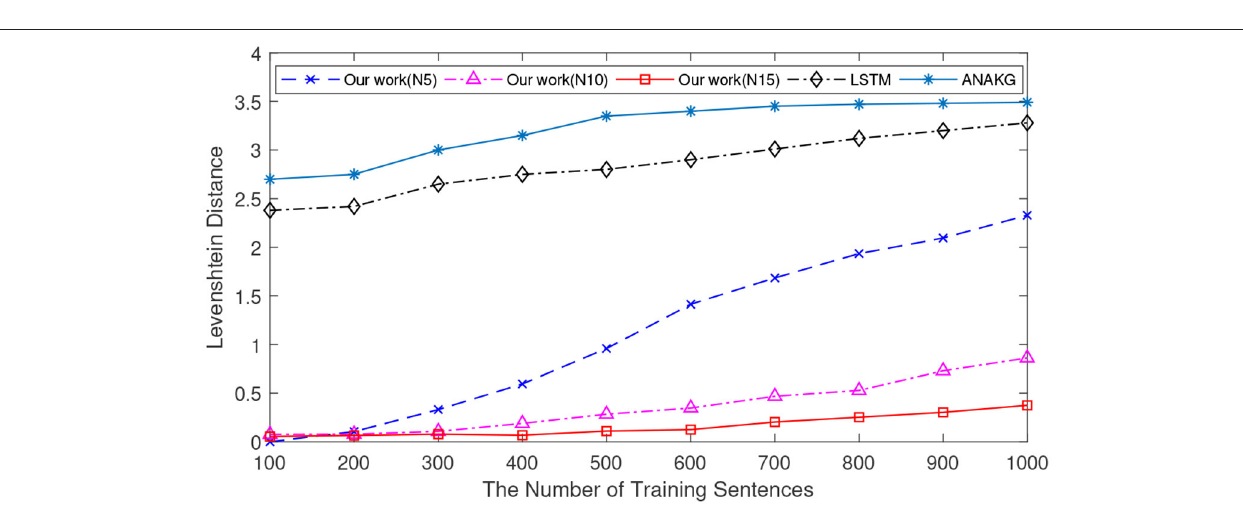
FIGURE 7 | The memory retrieval performance of the LSTM, the ANAKG, and our proposed model with different number of unique words. Our model is trained with different column size and “N5” means there are 5 neurons in each